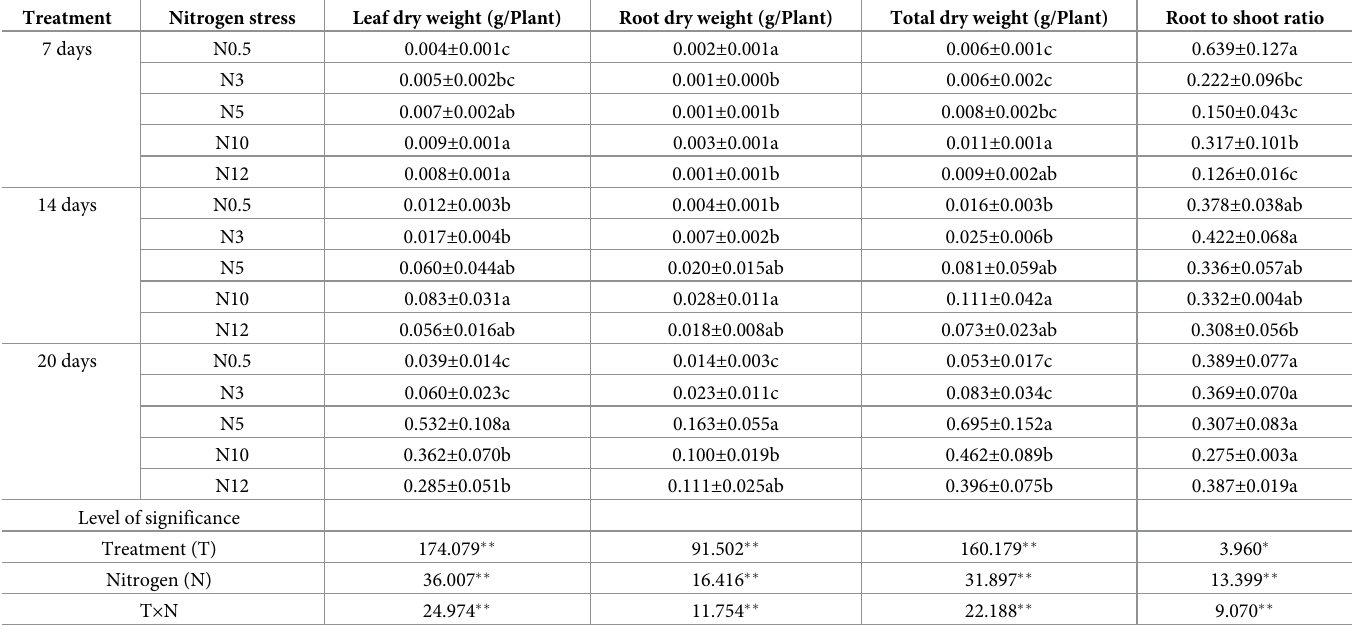
Table 3. Effects of different nitrogen treatments on sugar beet biomass.